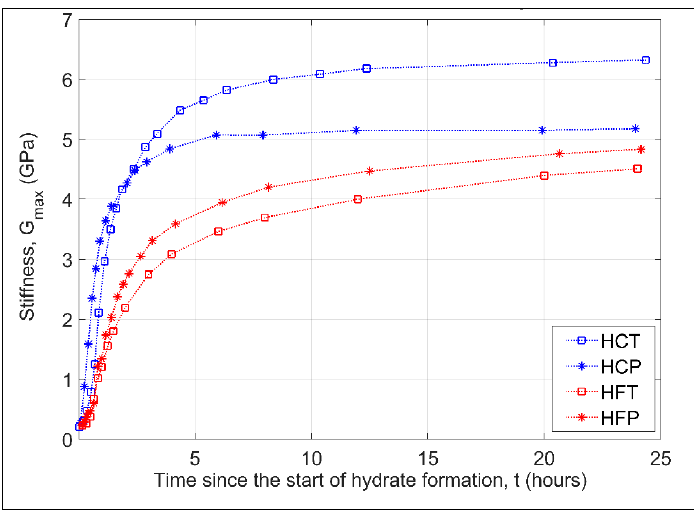
Figure 8. Change in stiffness during hydrate formation for the two different sands and two different formation paths utilized.